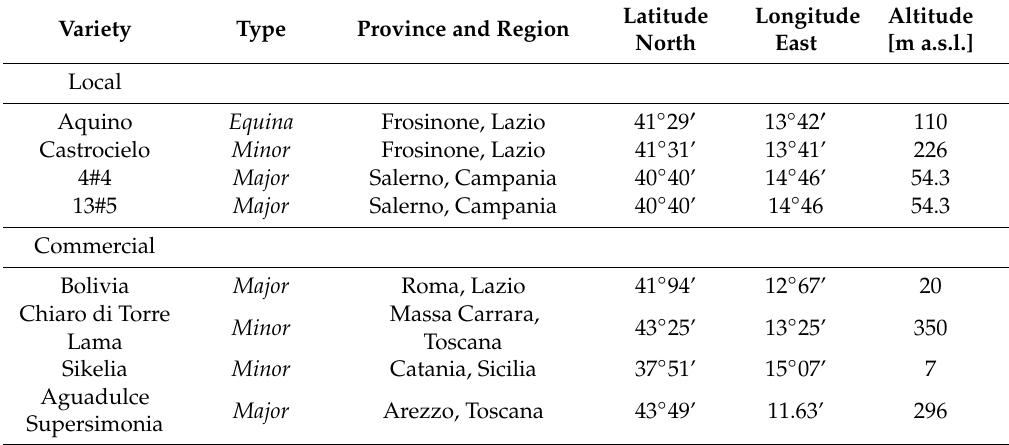
Table 1. Harvesting area of the Vicia faba L. varieties used for the field